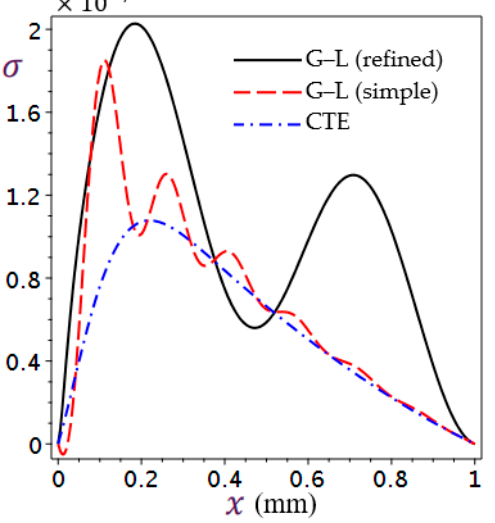
Figure 5. Two-dimensional plots of normal stress σ distributions in different theories of thermoelasticity.